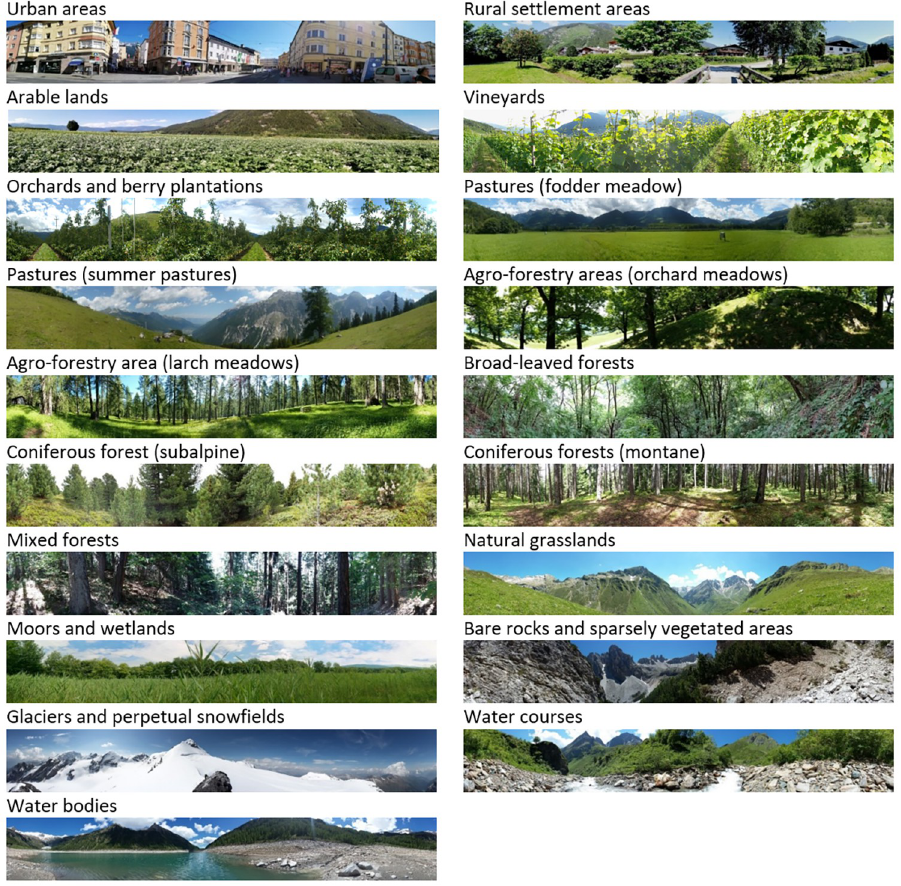
Fig 2. Examples of photographs representing 19 different LULC types. Photographs from Schirpke et al. [11], published under the Creative Commons CC BY 4.0 license.